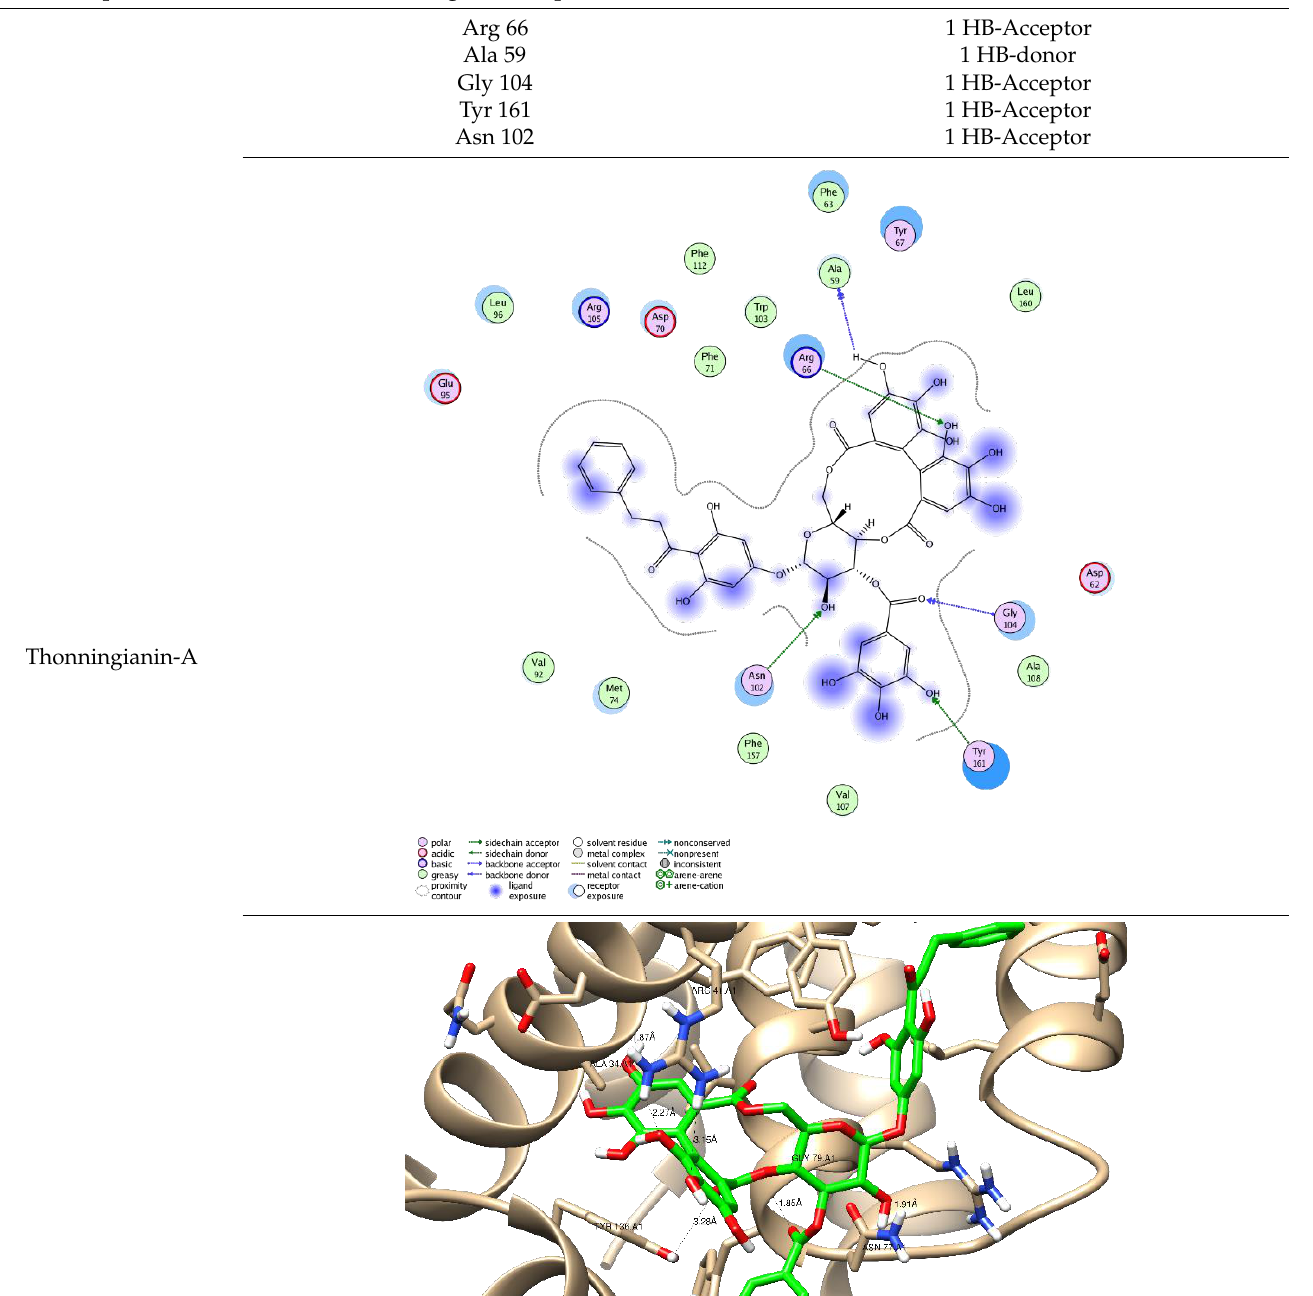
Table 4. Summary of the ligand – receptor interactions of the promising docked compounds inside the active site of Bcl-2 (PDB: 4IEH). Compound